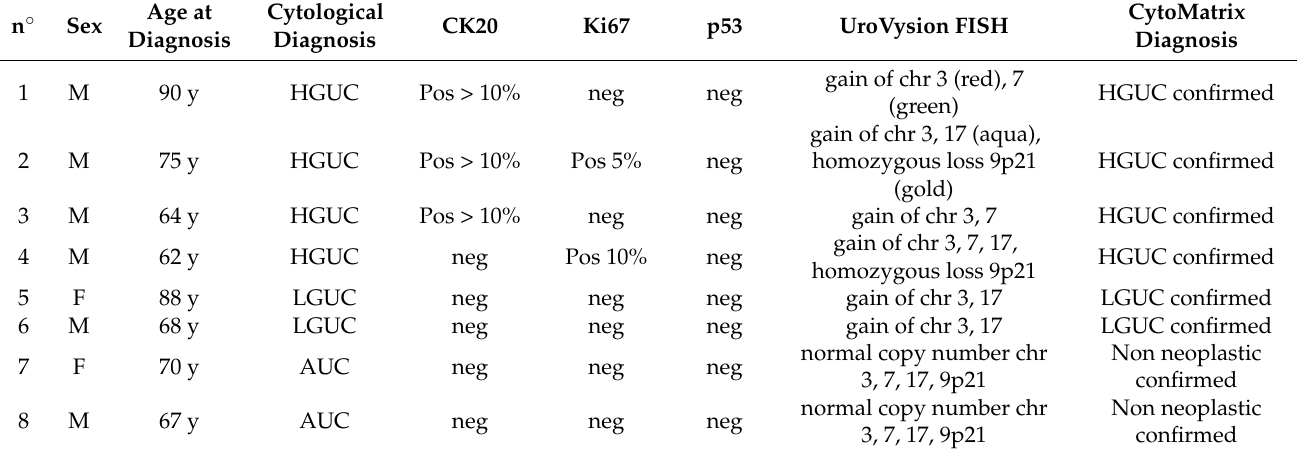
Table 1. Clinical and molecular features of urine samples analyzed with CytoMatrix assay, including information of initial cytological diagnosis. HGUC: high-grade urothelial carcinoma; LGUC: low-grade urothelial carcinoma; AUC: sample with presence of atypical urothelial